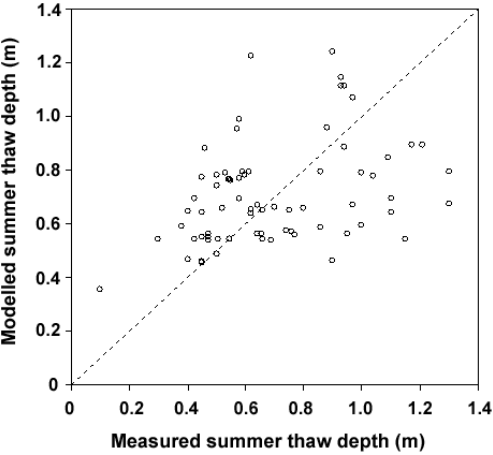
Figure 9. Comparison between the modelled and measured summer thaw depths. There are 71 observation sites where both observation and the model show the existence of permafrost. The correlation coefficient is 0.365 ( n =